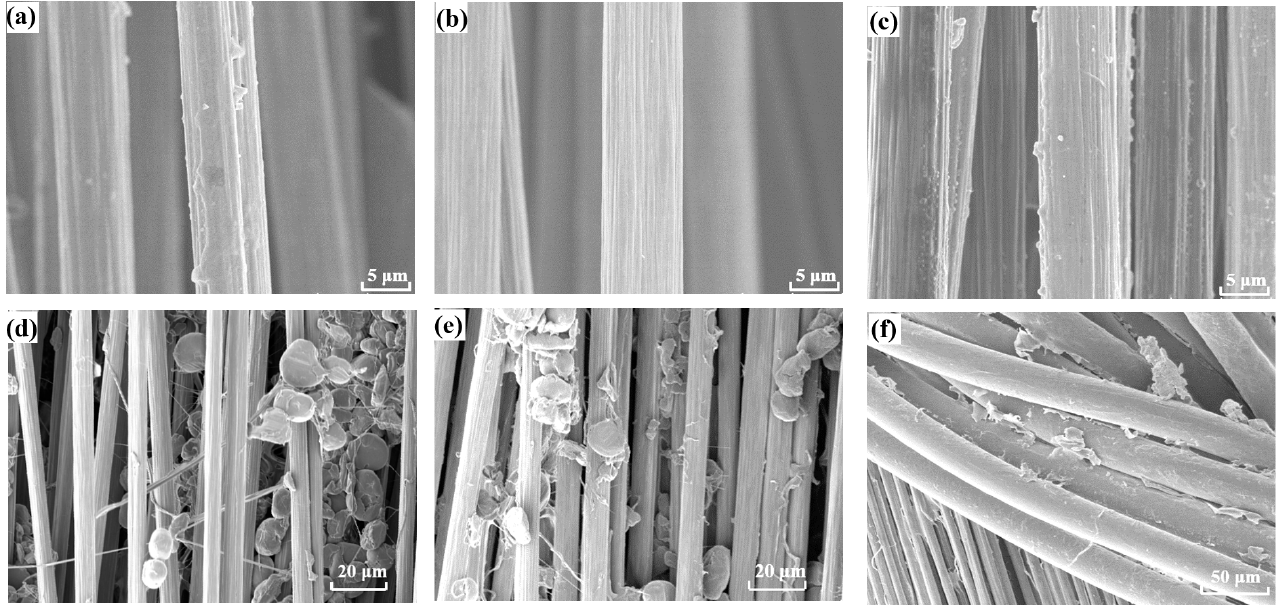
Figure 4. SEM images of ( a ) original, ( b ) desized, and ( c ) sized CF. ( d – f ) SEM images of ( d ) powder impregnated CCF/PEEK wrapped yarn, ( e ) after desizing, and ( f ) after sizing. impregnated CCF/PEEK wrapped yarn, ( e ) after desizing, and ( f ) after